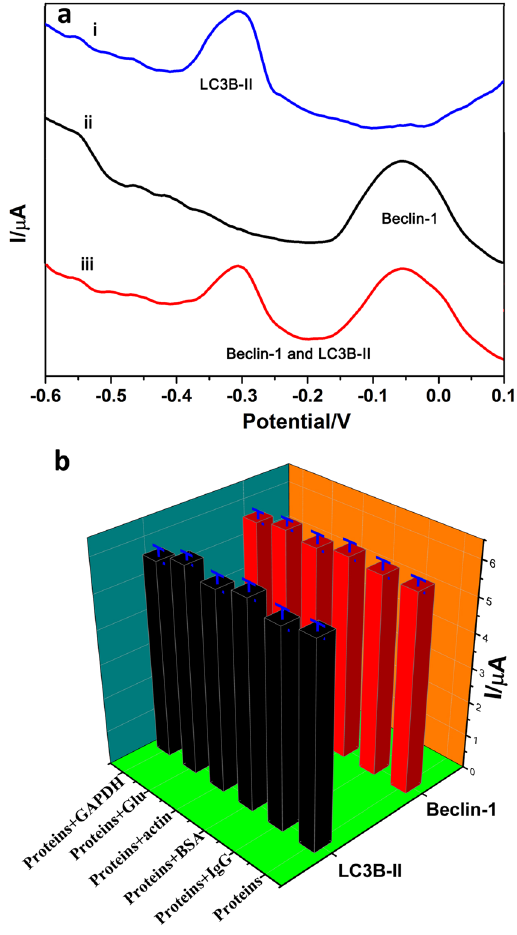
Figure 4. DPV responses of immunosensor in presence of various conditions ( a ): 10 ng/mL LC3B-II and 0 ng/ mL Beclin-1(i); 0 ng/mL LC3B-II and 10 ng/mL Beclin-1(ii); 10 ng/mL LC3B-II and 10 ng/mL Beclin-1(iii). Specificity of the immunosensor ( b ): current response of the immunosensor to 10 ng/mL LC3B-II and Beclin-1, and 100 ng/mL interfering substances of IgG, BSA, Actin, Glucose and